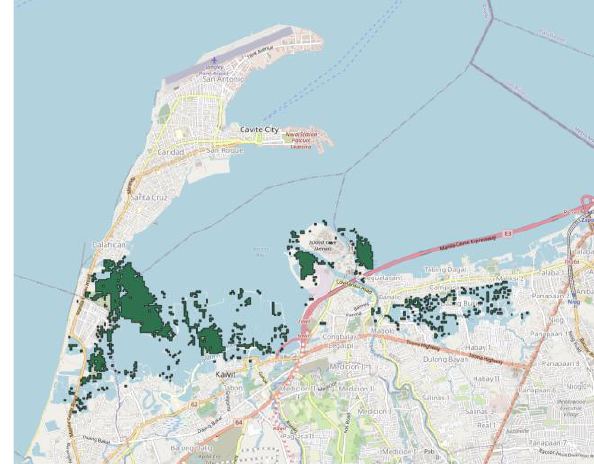
Figure 8. 2020 Mangrove Vegetation Index (MVI)-derived Mangrove map of Manila Bay. Landsat-5, Landsat-7, and Landsat-8 data were acquired from USGS/Earth Explorer. Shapefiles include mangrove maps of Manila Bay derived from